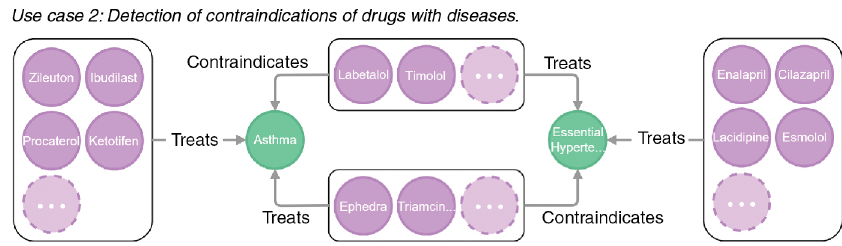
Figure 4: Network analysis for contraindications of